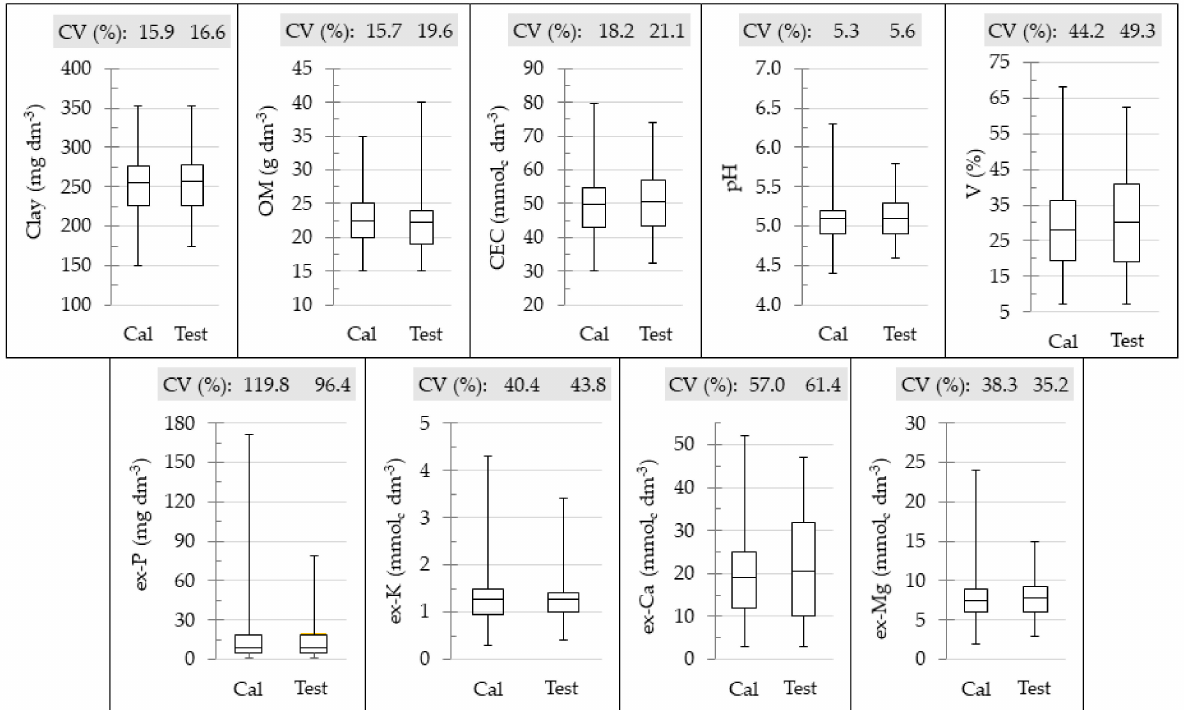
Figure 3. Box plots presenting the variation for the contents of clay, organic matter (OM), cation exchange capacity (CEC), pH, base saturation (V), and extractable (ex-) P, ex-K, ex-Ca, and ex-Mg for each calibration (Cal) and test datasets. The coefficient of variation (CV) is also presented above each box plot. Table 1. Spatial statistics and correlation matrix for the 347 samples collected in the calibration area. Soil sampling was carried out at a spatial density of about 20 samples ha − 1 .